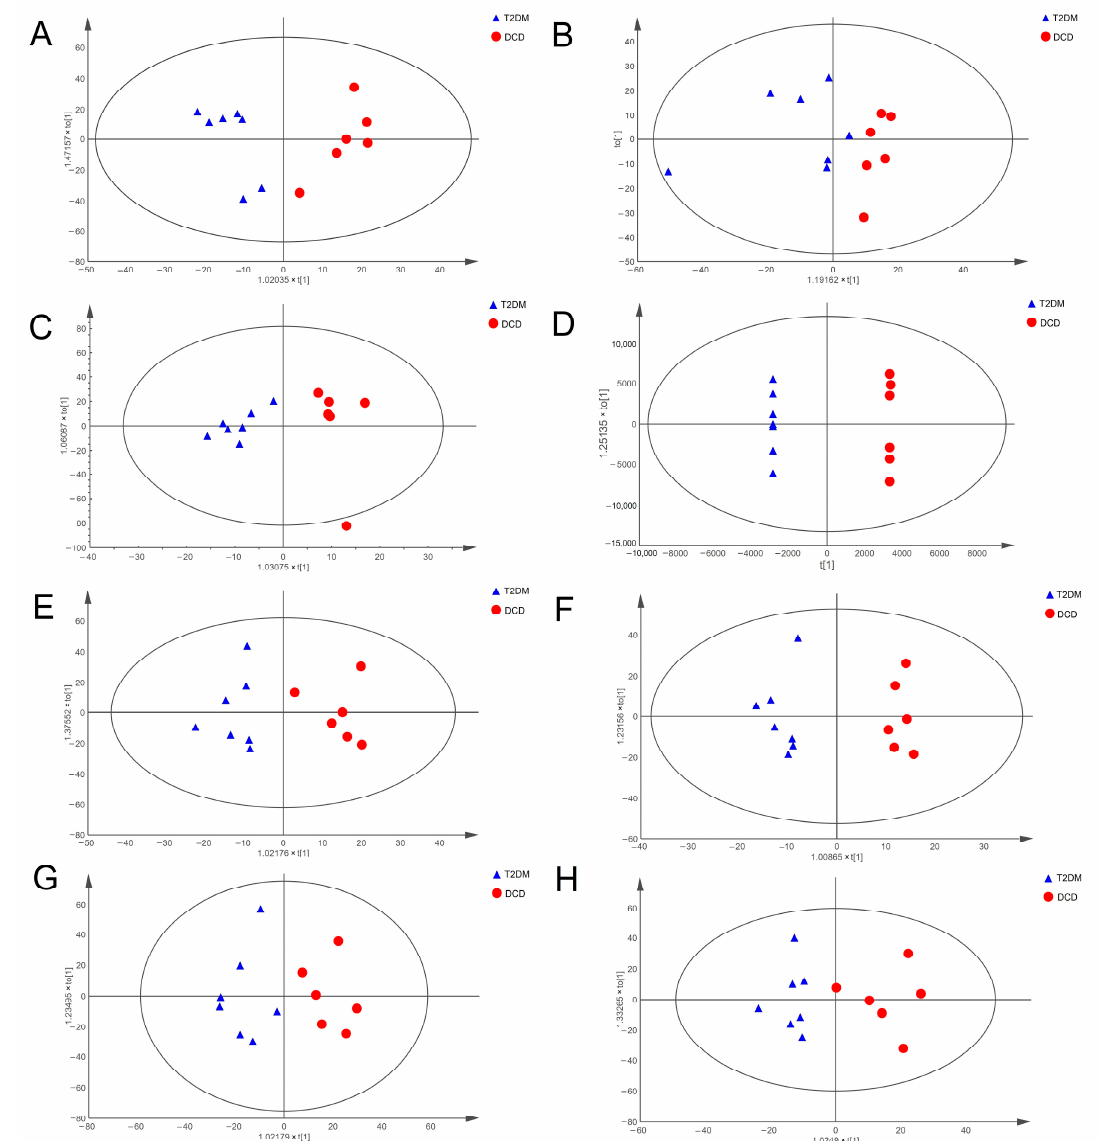
Figure 3. OPLS-DA models of hippocampal tissue and urine. OPLS-DA score plots of hippocampal tissues in positive ( A ) and negative ion modes ( B ) using the HILIC column; OPLS-DA score plots of hippocampal tissues in positive ( C ) and negative ion modes ( D ) using the RP column; OPLS-DA score plots of urine in positive ( E ) and negative ion modes ( F ) using the HILIC column; OPLS-DA score plots of urine in positive ( G ) and negative ion modes ( H ) using the RP column.